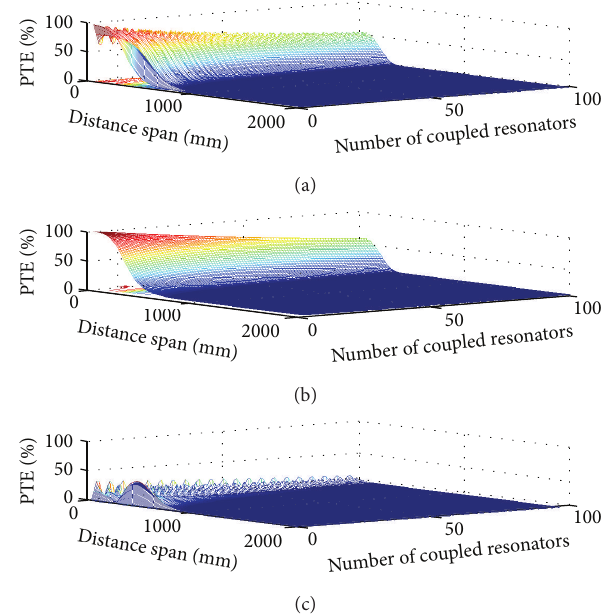
Figure 11: PTE versus the number of coupled resonators and distance span for practical DCR configurations. (a) Theoretical analysis. (b) Approximate CSM method. (c) Absolute difference between theoretical analysis and approximate CSM